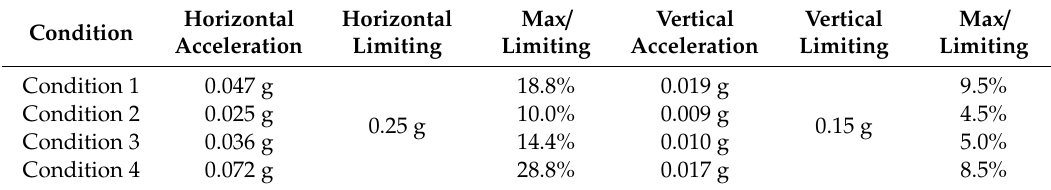
Figure 16. Z -axis vibration acceleration at the top of the tower. Table 5. The maximum values of the vibration acceleration of the tower.